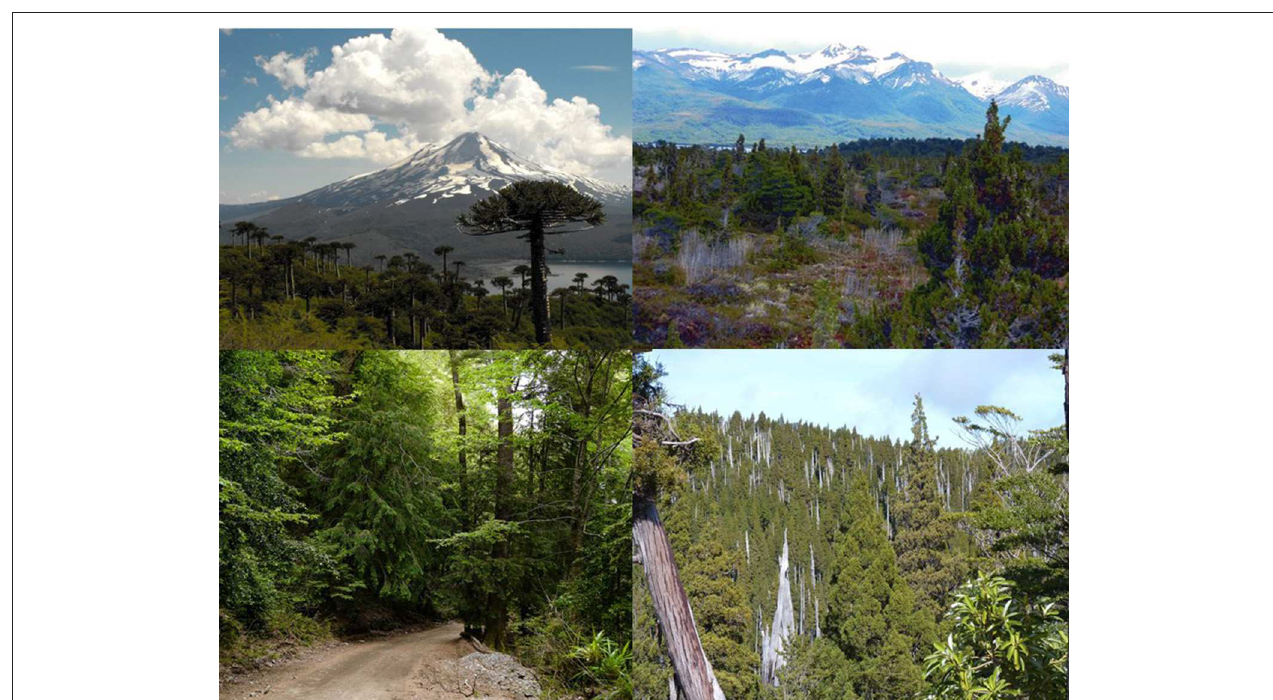
FIGURE 5 | Endemic Chilean conifers. Araucaria araucana , Araucariaceae (photo by lautaroj); Pilgerodendron uviferum , Cupressaceae (photo by Rodolfo Iturraspe); Podocarpus nubigenus , Podocarpaceae (photo by Fedwerner); Fitzroya cupressoides , Cupressaceae (photo by Mono